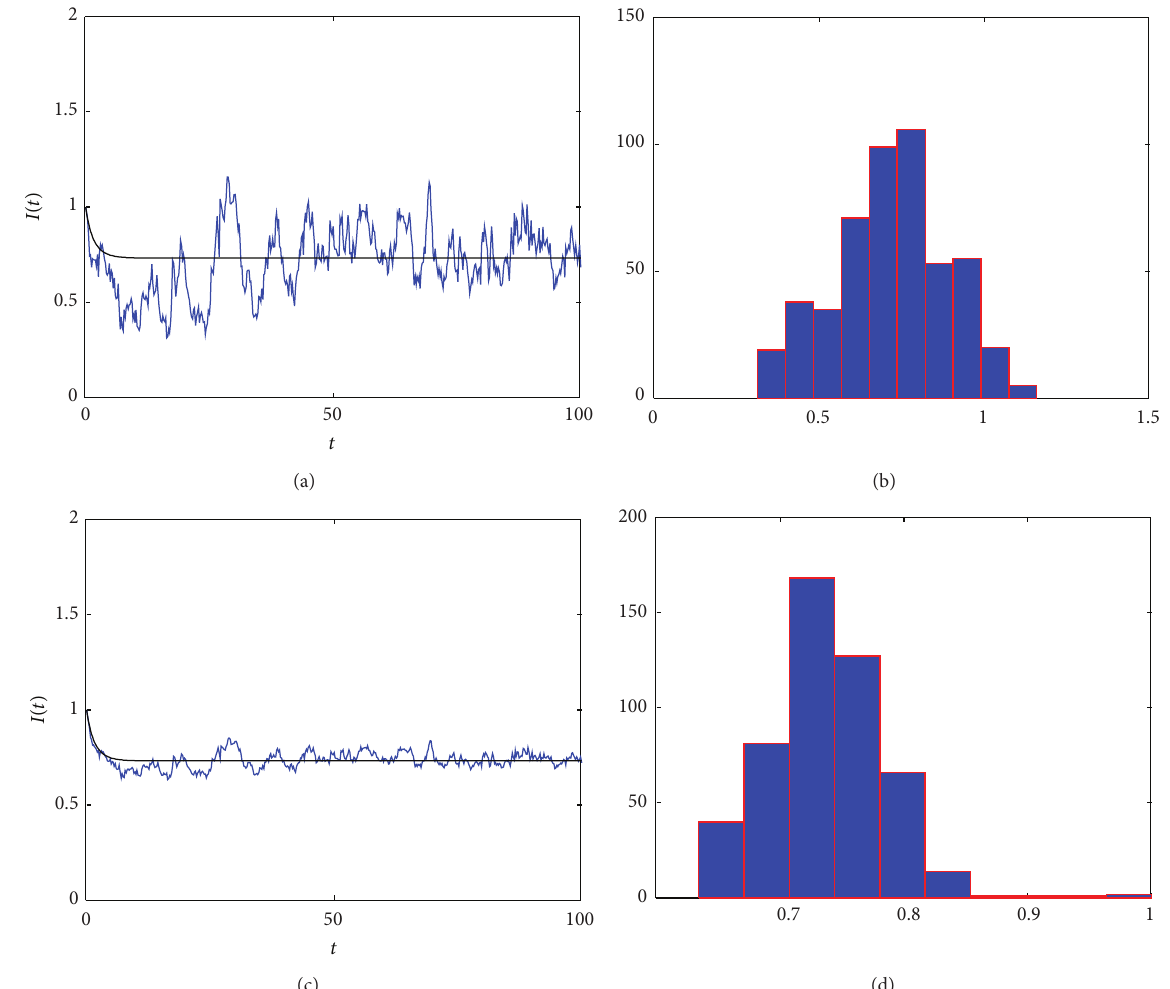
Figure 2: The solution 𝐼(𝑡) of SIS model (7) and its histogram with differing value of 𝜎 = 0.2, 0.05